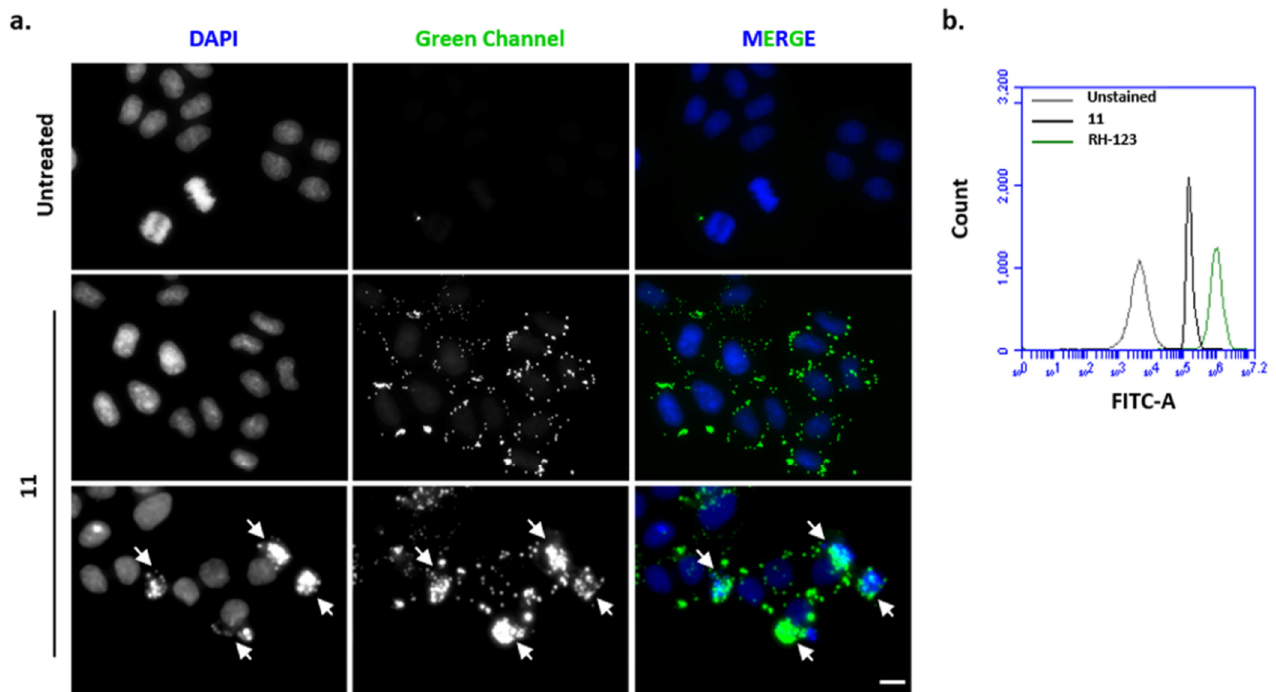
Figure 3. Cancer cells treated with compound 11 emitted fluorescence in the green channel. ( a ) Representative images of untreated (top) and compound 11 -treated cells (middle and bottom), showing intracellular green fluorescence as emitted by the compound. Middle: representative microscopic field showing (still) living cells treated with the compound: intact nuclei can be seen after DAPI staining of DNA (blue); in the green channel, fluorescence staining of the compound is seen in the cytoplasm, excluding the nuclei. Bottom: representative microscopic field showing treated cells undergoing cell death (white arrows): micronuclei can be seen after DAPI staining (blue), and a bright fluorescence is seen due to chromatin overcondensation and shrinking of dead cells. Bar, 5 µm. ( b ) Representative flow cytometry histogram of cell count versus FITC-A intensity in untreated (unstained) and compound 11 -treated cells. Rhodamine-123 green fluorescent dye was used as positive control.